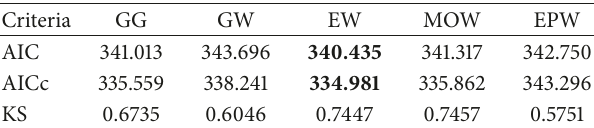
Table 3: Results of AIC and AICc criteria and the 𝑝 value from the KS test for all fitted distributions considering the Pricker A.